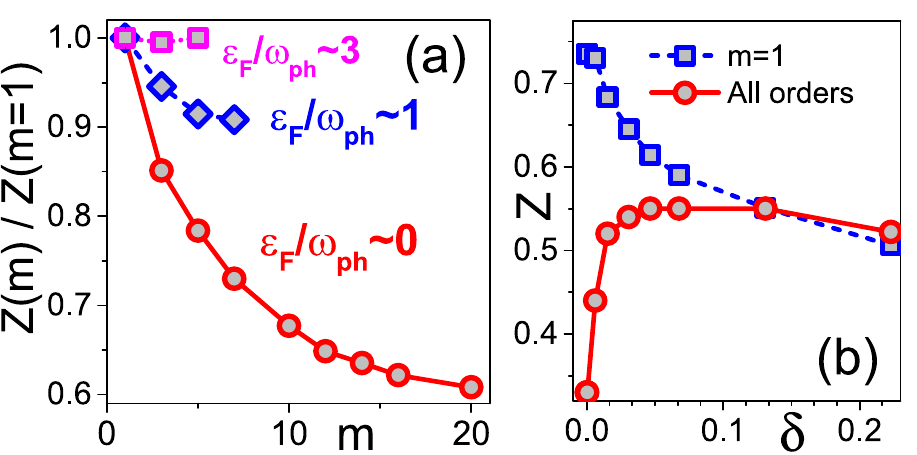
1 = 4 ), γ 3.8 10 0 ( δ 0.71 − = × → = 1 result (squares), =